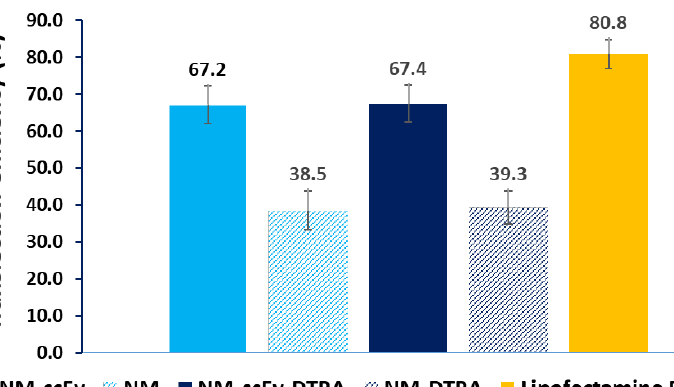
Figure 5. Anti-Luciferase siRNA transfection efficiency of different NM-scFv and the optimized NM-scFv-DTPA into H460-Luc cancer NM-scFv-DTPA into H460-Luc cancer cells.